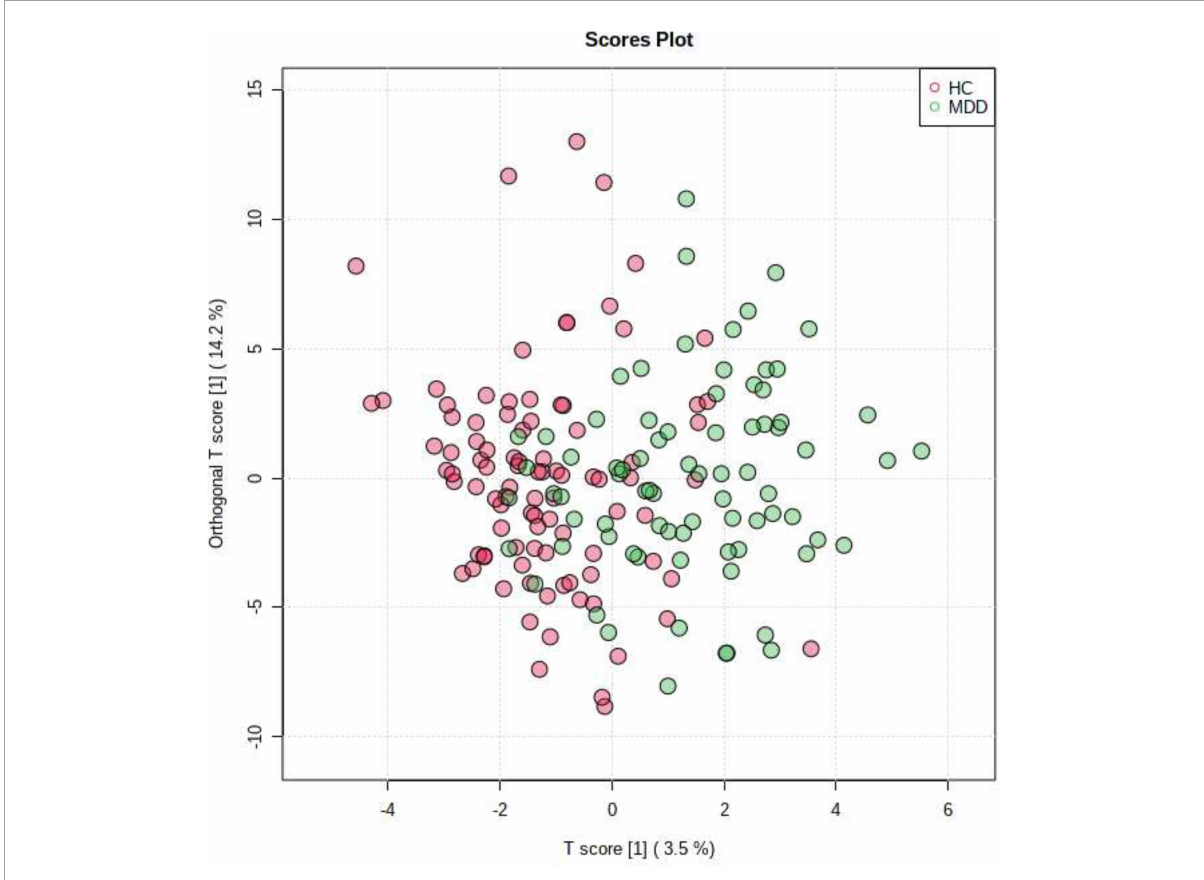
FIGURE3 Orthogonal partial least squares discriminant analysis (OPLS-DA). OPLS-DA showed a relatively clear separation from PCA between patients in MDD group and HC group by the first principal